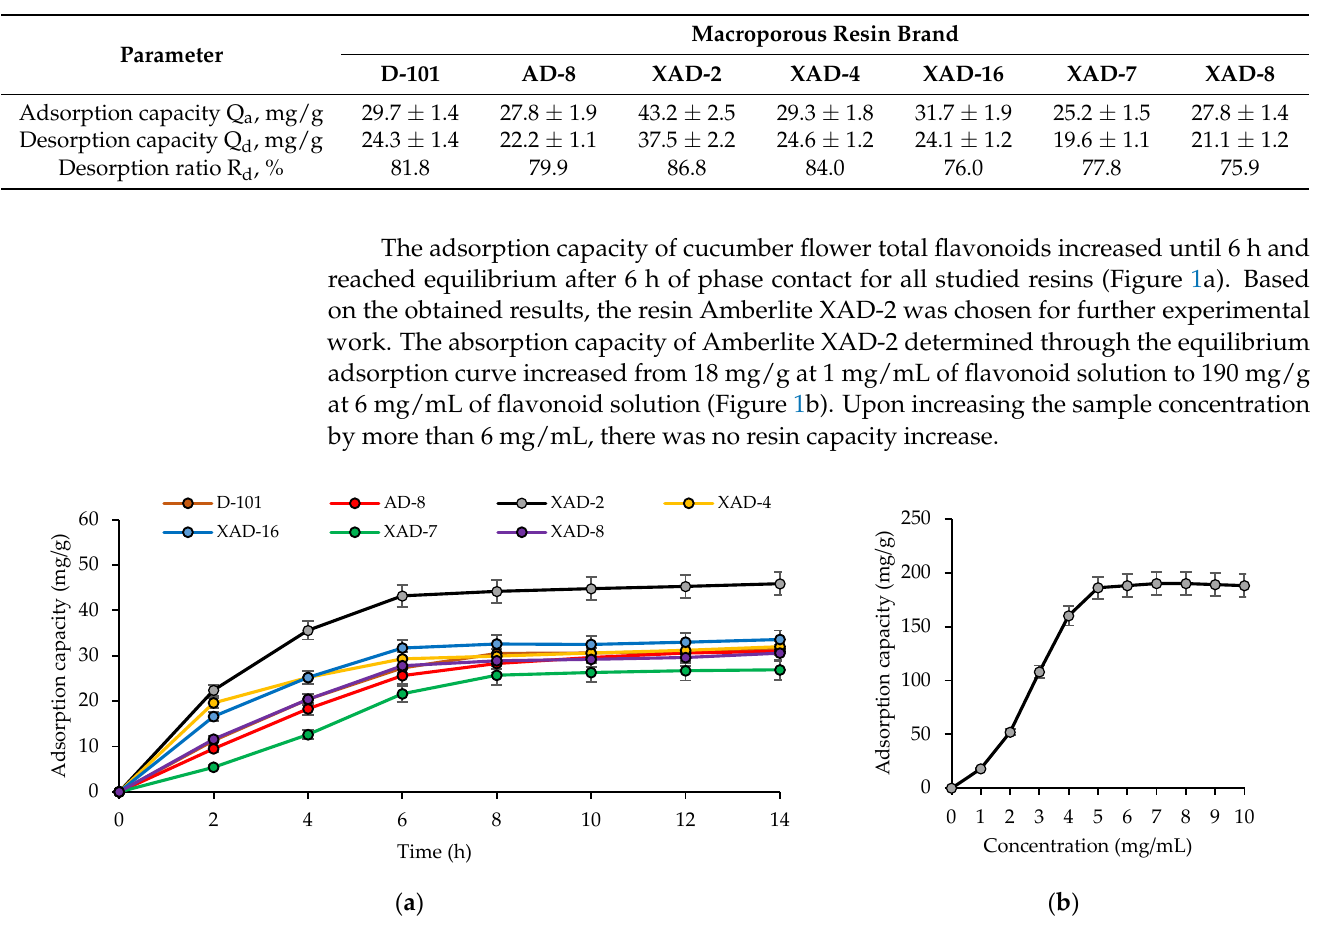
Table 3. Adsorption and desorption properties of seven macroporous resins.